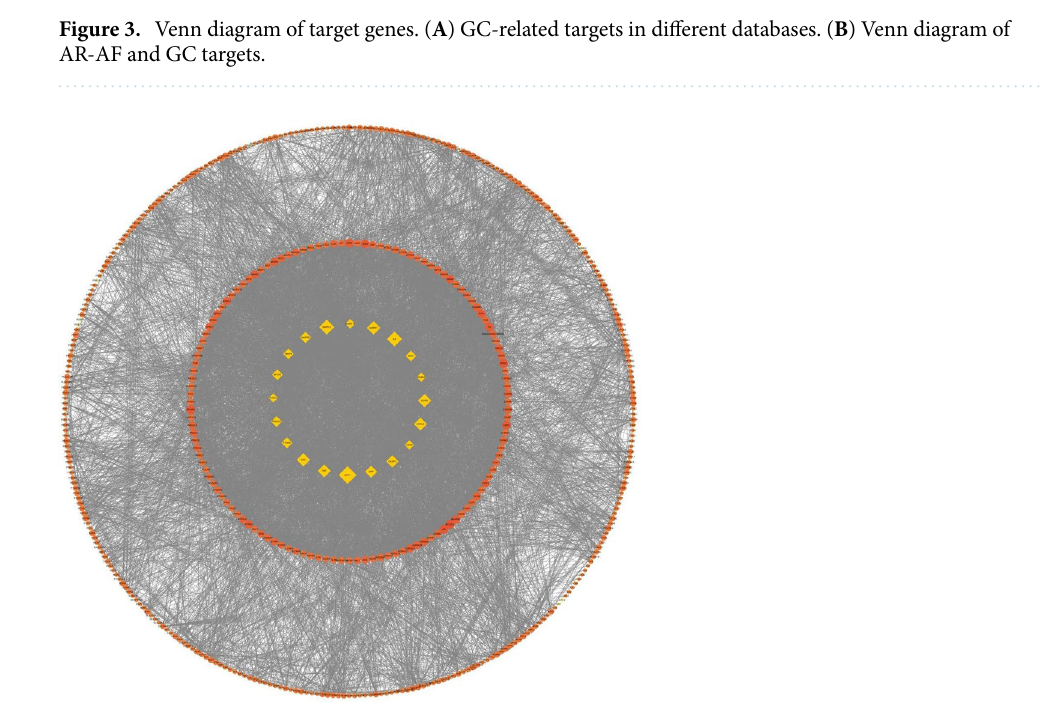
Figure 4. The PPI network. Yellow diamonds represent the top 20 genes in all nodes with degree ≥ 83. Orange circles represent the genes with degree < 83. Node size and color were set to reflect the degree value. The greater the degree value is, the darker the color and the larger the